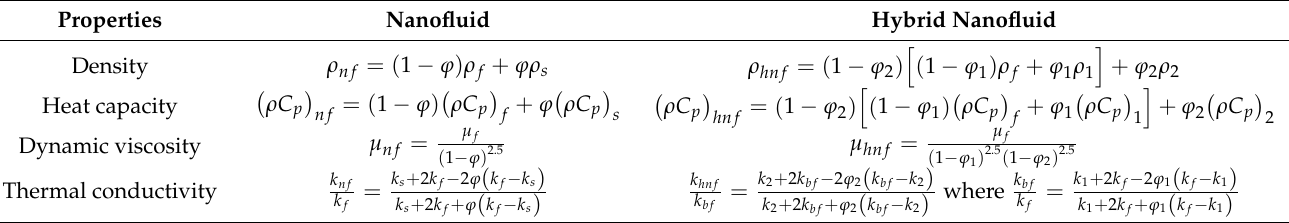
Table 1. Physical properties of hybrid